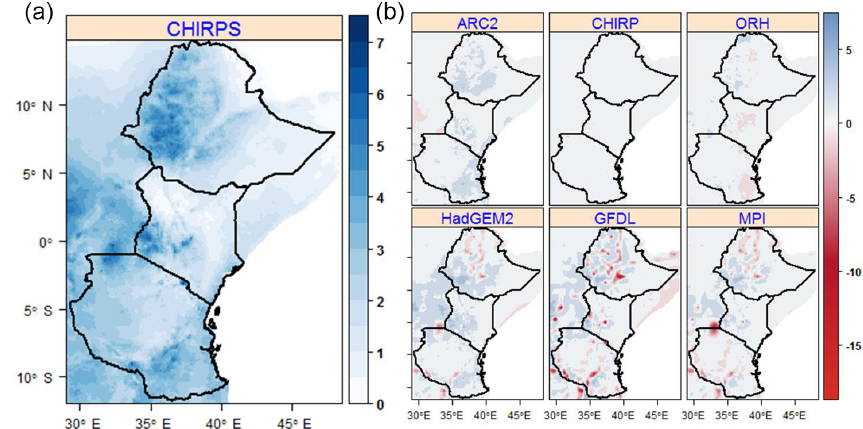
Figure 6. Average daily rainfall (mmday − 1 ) map of East Africa retrieved from CHIRPS (a) for the study period 1983–2005. For rainfall data from ARC2, CHIRP, ORH, and RCMs (b) , the absolute difference (mmday − 1 ) from CHIRPS is displayed. All the maps are given in a 0.05 ◦ spatial